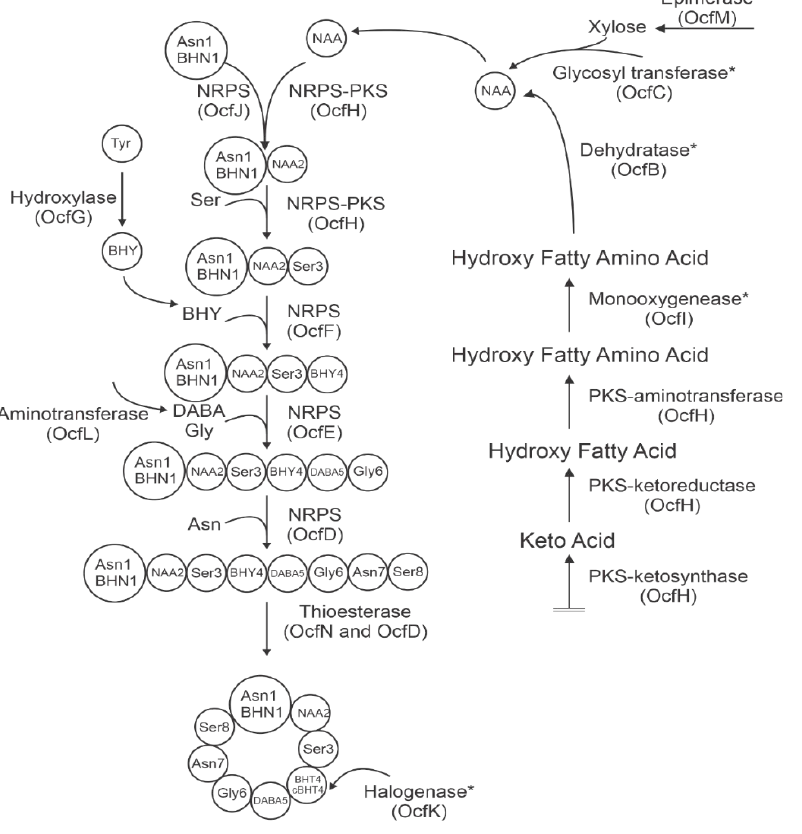
Figure 2. Biosynthetic pathway of occidiofungin consisting of a polyketide synthase pathway and non-ribosomally synthesized peptide synthase pathway. Steps which are uncertain in when they occur are marked with an asterisk. Adapted from Gu et al [12].